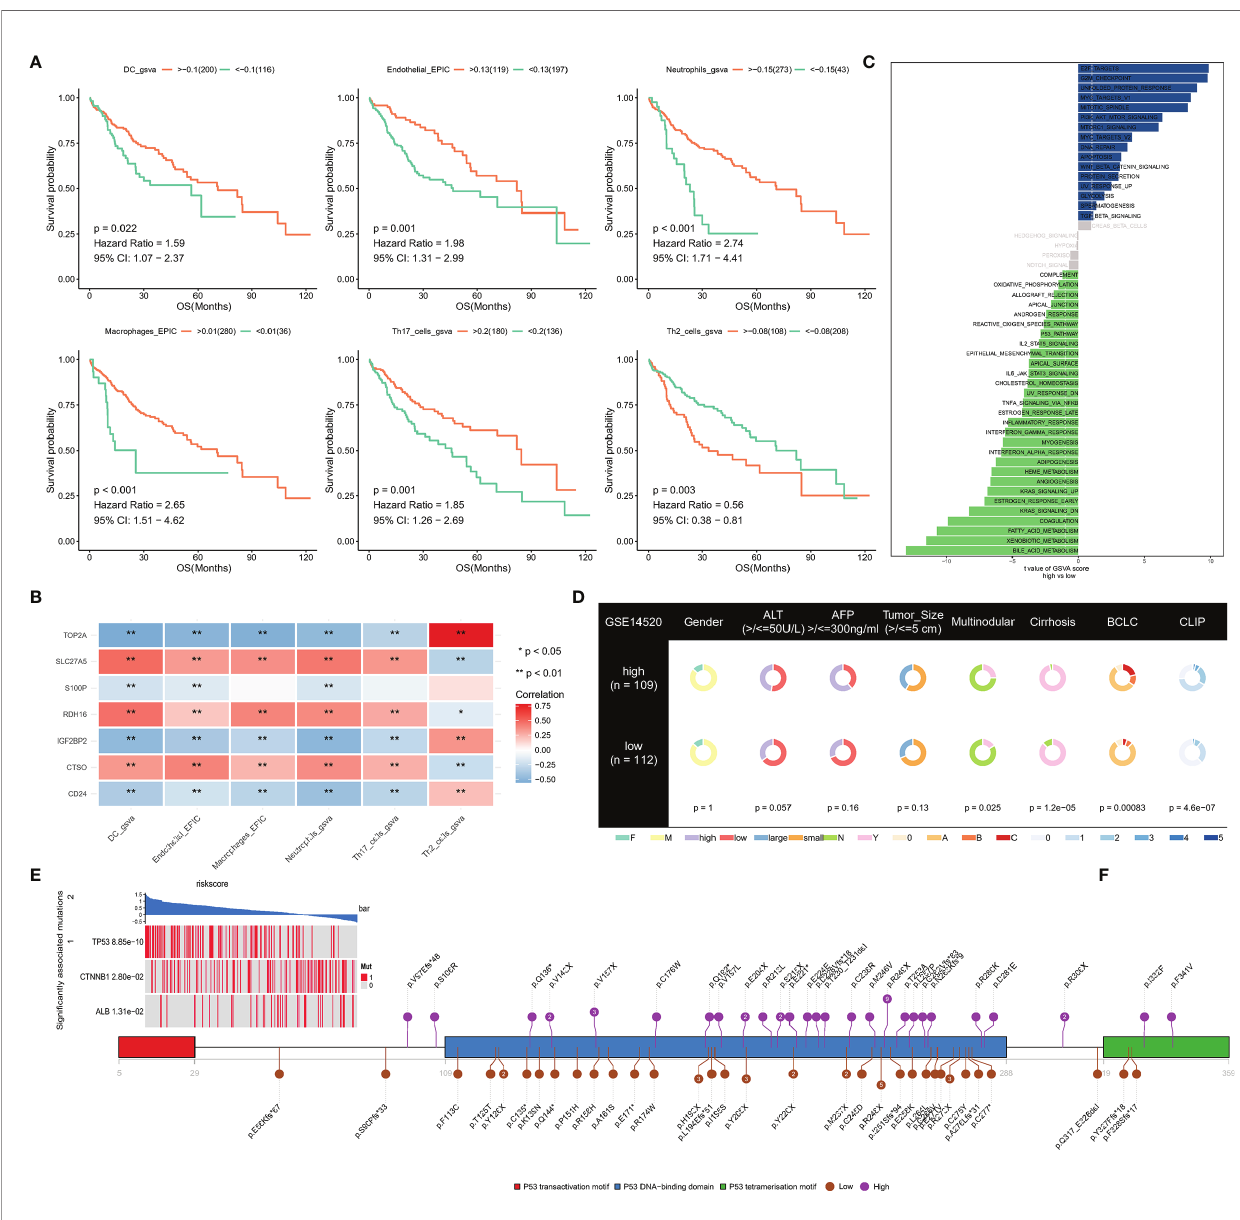
FIGURE 6 | (A) Survival analysis of immune cells; (B) The correlation between signatures and immune cells; (C, D) Difference of hallmark pathways and clinical phenotypes between low- and high-NRS groups; (E) Mutant genes that are statistically different between low- and high-NRS groups; (F) mutation sites of TP53 in high- and low-NRS groups are independently summarized. *p<0.05,